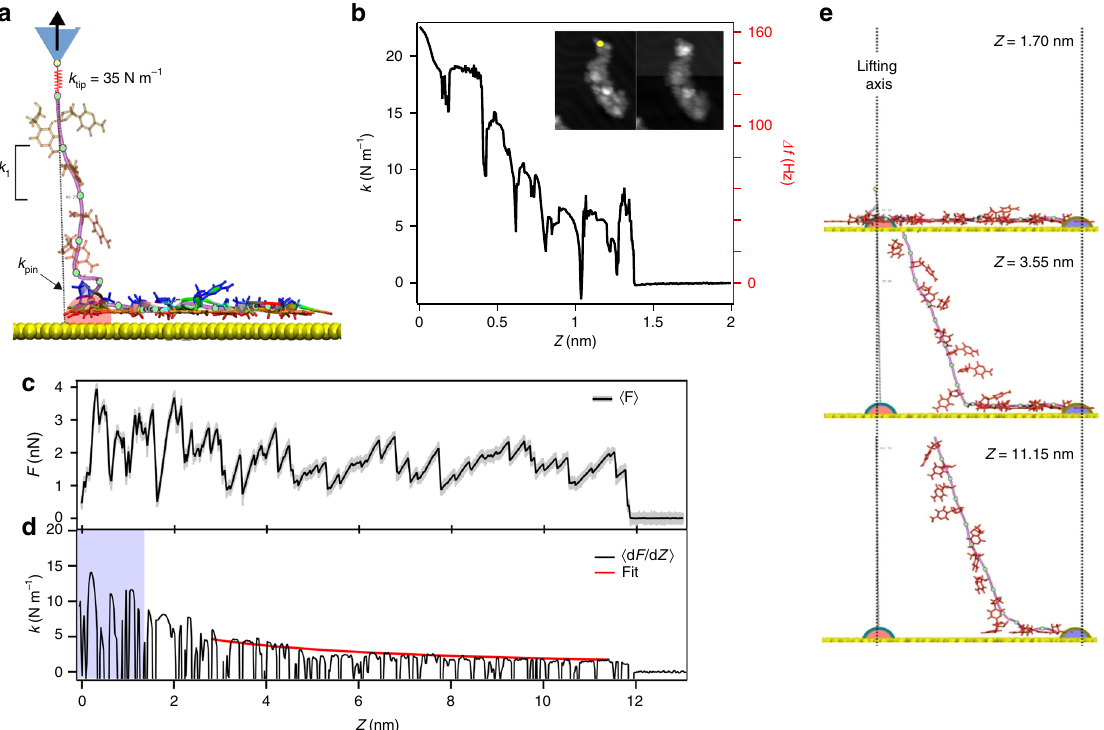
Fig. 3 Mechanical response while lifting a ssDNA oligomer from Au(111). The oligomer is attached at one end to the AFM tip and pulled vertically at constant velocity. a Schematic of the lifting simulations. b Experimental retraction trace, k (Z) ∝ Δ f (Z) recorded at 4.8 K. c Force – distance curve F (Z) obtained from MD simulations assuming k tip = 35 N m − 1 and d the corresponding computed stiffness k (Z). The blue area shows the Z -range accessed by the experiment. The red curve shows the fi t to k maxima according to Eq. (1) with k 1 = 32.6 ± 3.9 N m − 1 , k pin = 18.3 ± 3.3 N m − 1 , and b cos θ = 0.64 ± 0.05. e Side views of the ssDNA oligomer after lifting 0, 10, and 17 nucleotides revealing the nearly straight con fi guration of the detached inclined by θ (almost 18° between n = 8 and 18 according to Fig. 3e and the corresponding Supplementary Movies 1 and 2). The resulting fi t (red curve) is superimposed on the computed dF / dZ trace in Fig. 3d obtained for k tip = 35 N m − 1 . The resulting parameters are k 1 = 32.6 ± 3.9 and k pin = 18.3 ± 3.3 N m − 1 . This